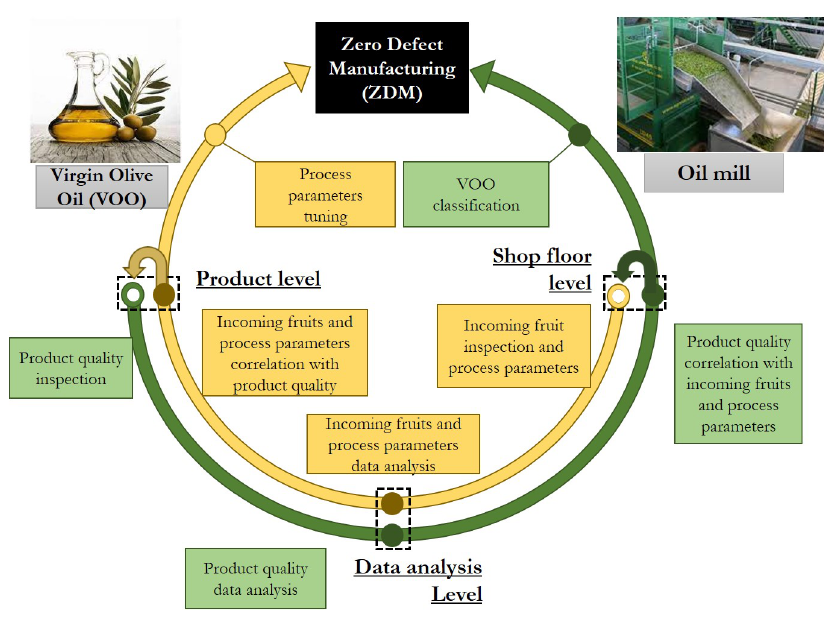
Figure 2. Zero defect manufacturing strategy designed for the virgin olive oil